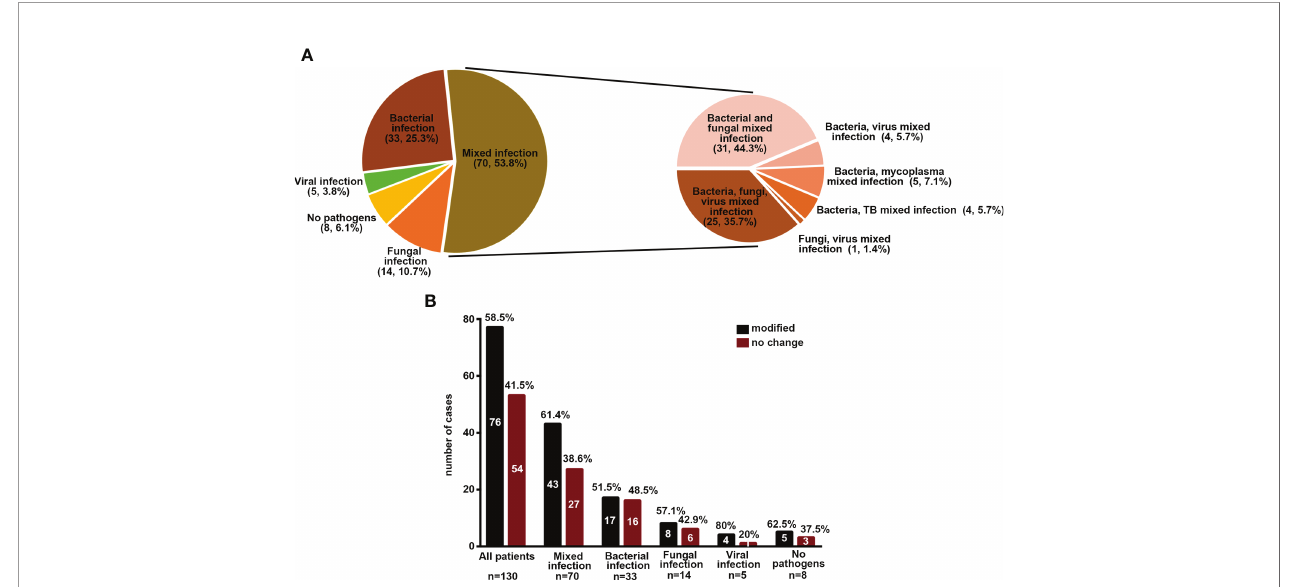
FIGURE 3 | Implications of mNGS and conventional methods in different infection types. (A) Percentage of patients with different infection types. (B) The percentage of patients with modi fi ed treatment